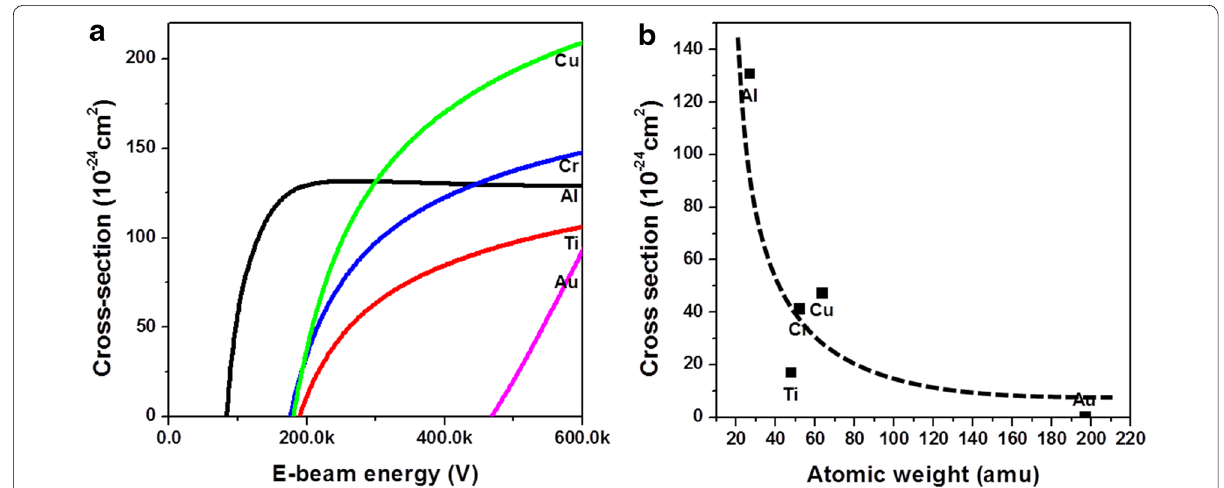
Fig. 1 a Calculated σ d as a function of E and b σ d as a function of atomic weight for E